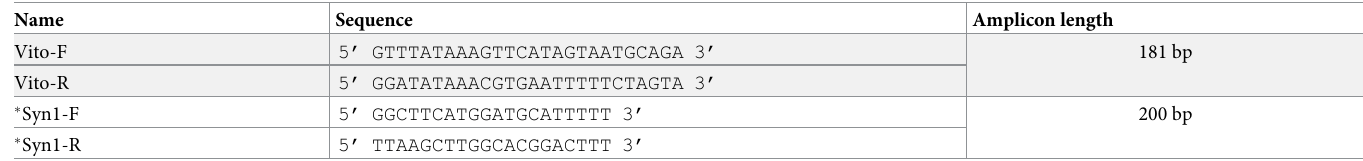
Table 1. Sequences of primers used in qPCR. The sequences of the primers based on data published by Lord and coworkers [19] are marked with �